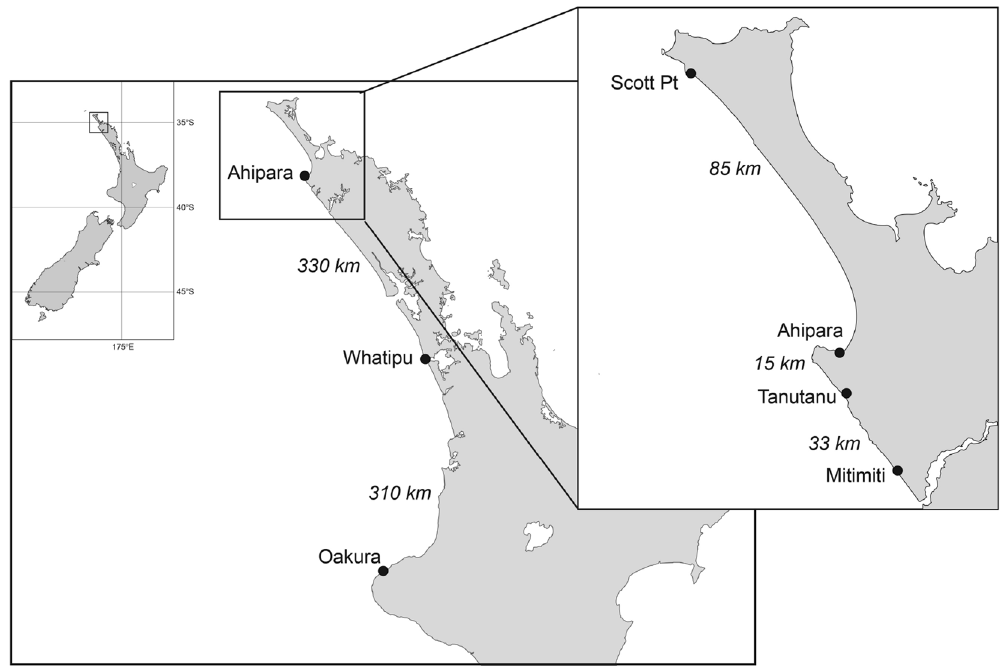
Figure 4. Location of sampling sites from which green-lipped mussels ( P. canaliculus ) were collected along the west coast of the North Island of New